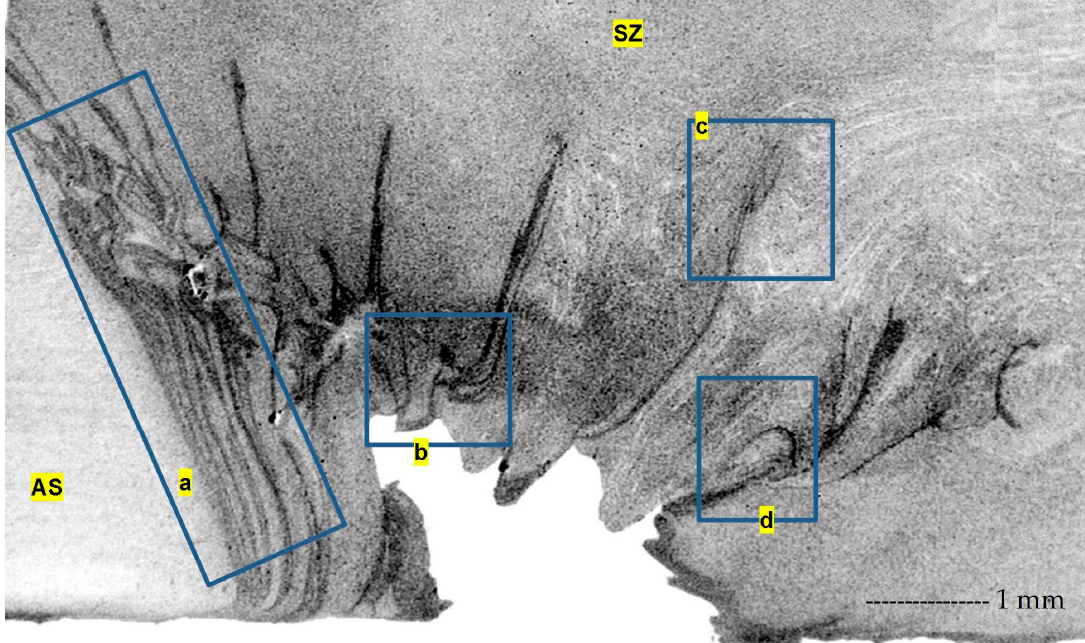
Figure 5. Micrograph of the tunnel void and the microflow features around the defect at the circumferential side of the tunnel void (revealed by Reagent C). ( a ) Cascade flow bands, ( b ) hook lines, ( c ) finger pattern, ( d ) swirling lines.